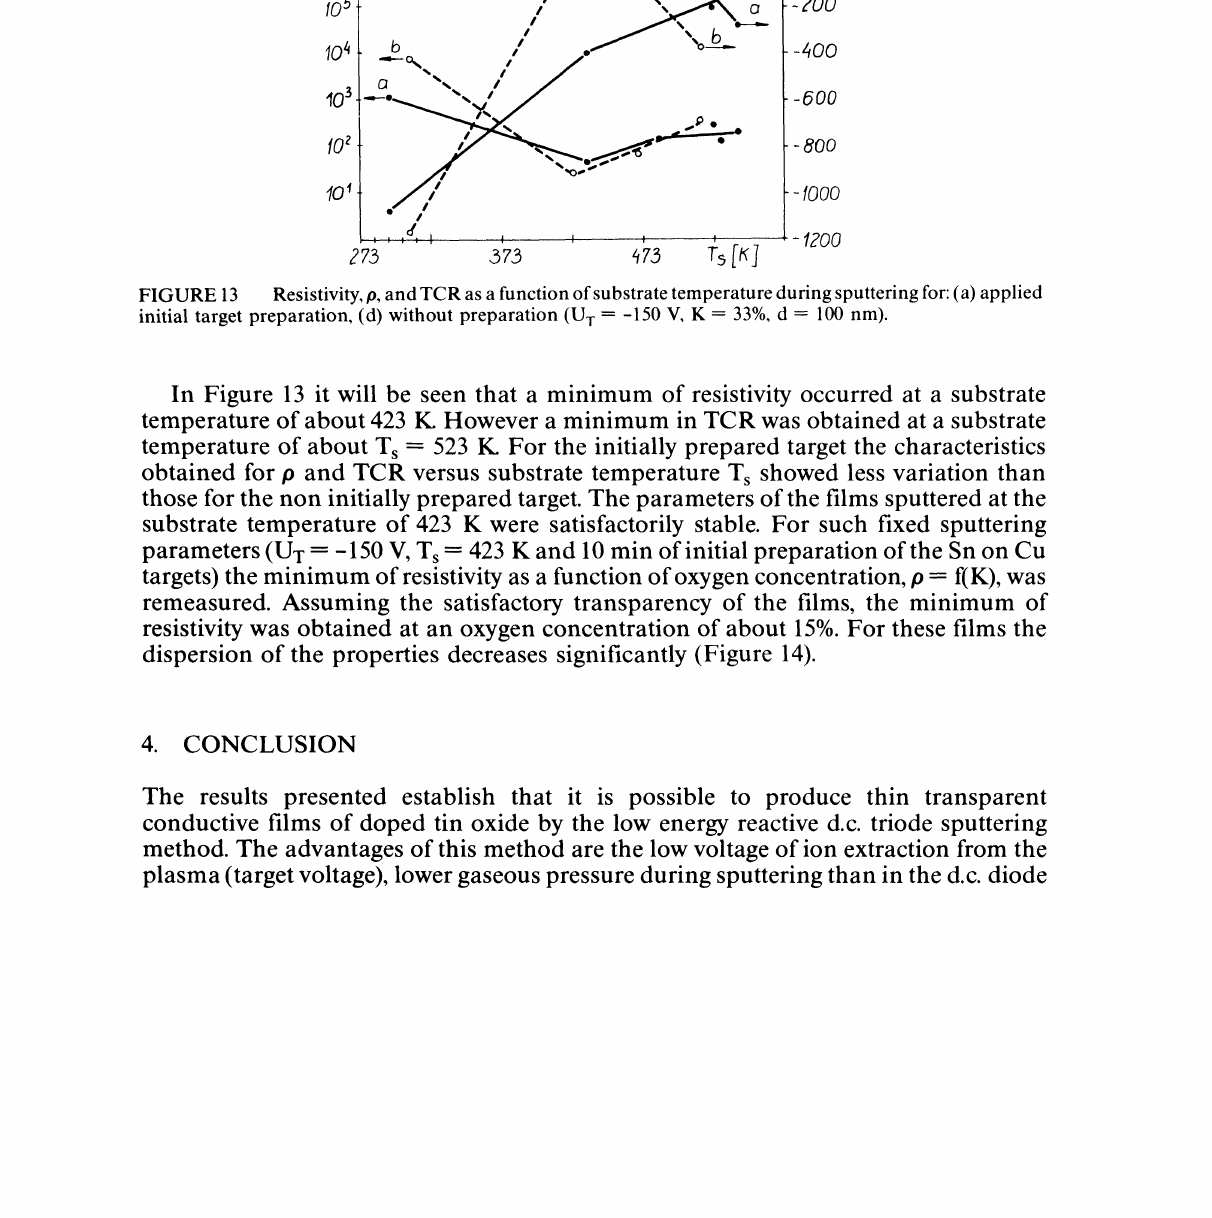
Deposition rate as a function ofsubstrate temperature during sputtering for: (a) applied initial target preparation, (b) without preparation (U r 150 V, K 33%, d 100 nm).